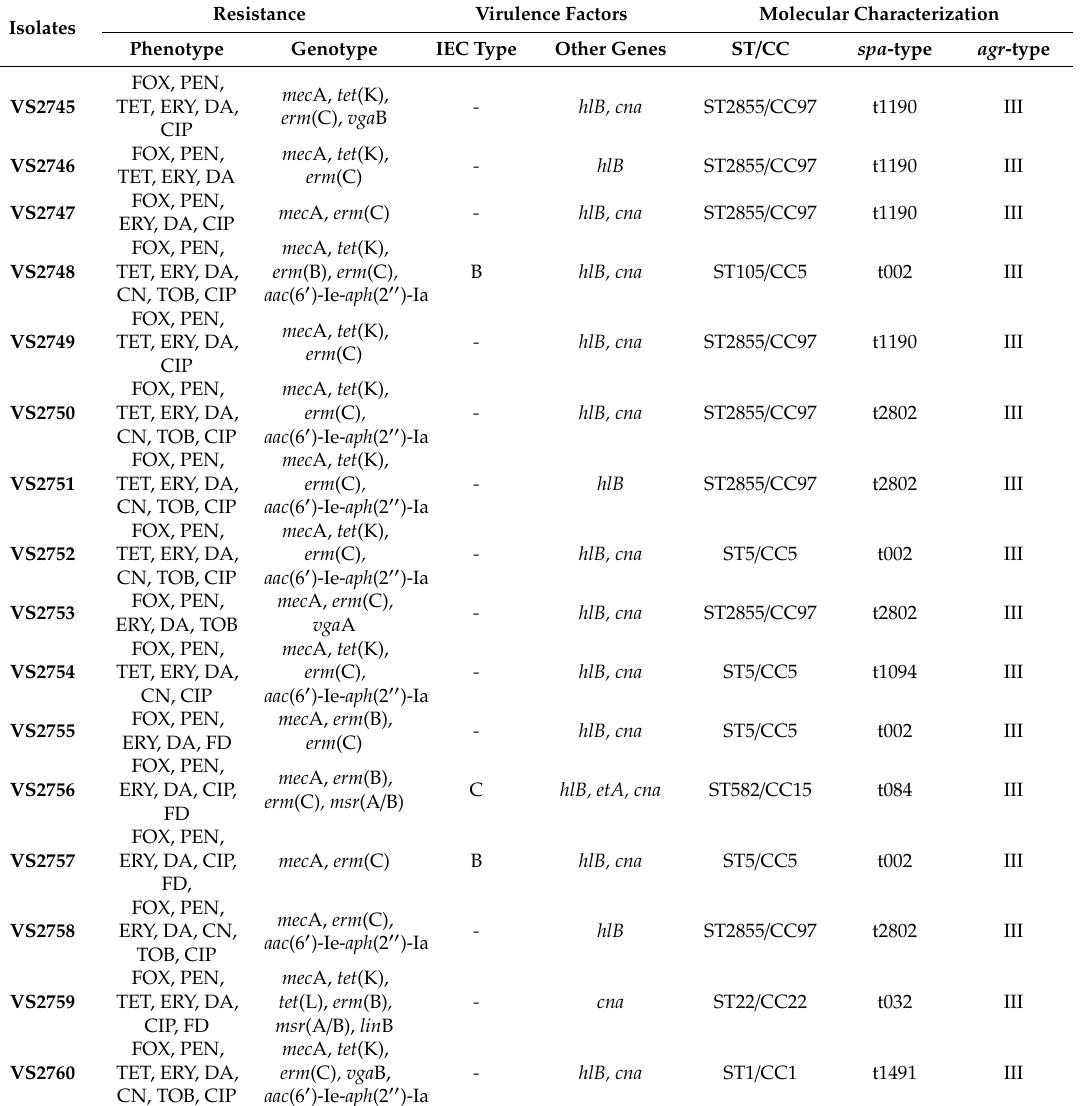
Table 1. Genetic characterization of antibiotic resistance and molecular typing of